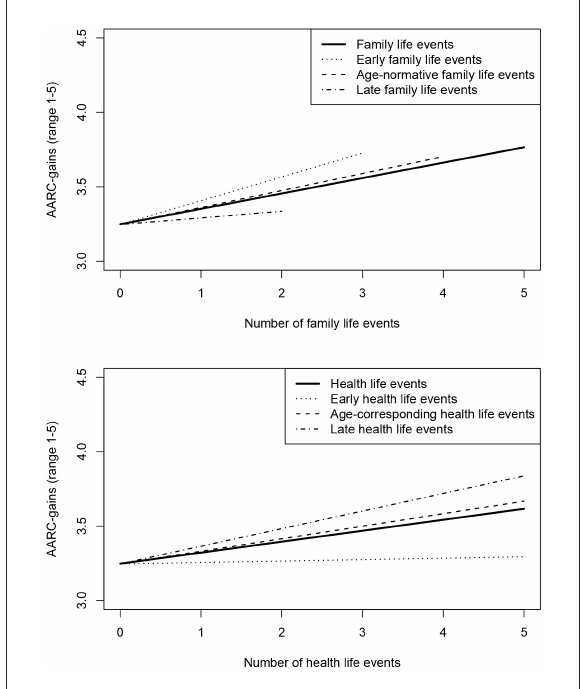
FIGURE1 Number of life events and awareness of age-related gains. Regression lines cover the maximum number of life events occurring in the sample.